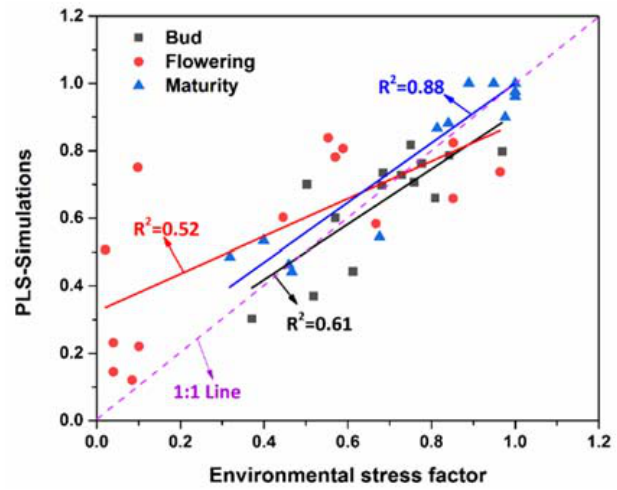
Figure 6. PLSR prediction of environmental stress factors of bud (black squares), flowering (red dots), and maturity (blue triangles) stages under the influence of soil salinity. Lines indicate linear fitting, and the dashed purple line is the 1:1 line.